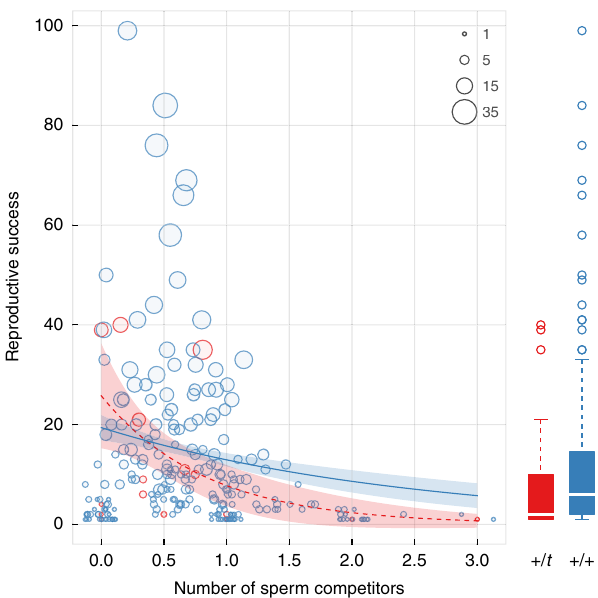
Fig. 2 Sperm competition damages the fi tness of t haplotype males. The fi gure shows the reproductive success of 249 males as a function of sperm competition intensity (measured as the number of sperm competitors a male encountered during his lifetime) and t genotype (red for + /t and blue + / + males). Dot size is proportional to the number of litters in which a male sired at least one offspring. Red/dotted and blue/solid lines with shaded areas show mean GLM model predictions and 95% con fi dence bands for + /t and + / + males, respectively (based on a hypothetical male that reproduced 10 times). Reproductive success was lower in males that were exposed to elevated levels of sperm competition, but the effect is particularly strong in drive carrying males. Low drive male fi tness under sperm competition translated into a lower reproductive output of + /t males overall, as illustrated by boxplots on the right (showing median (line), 0.25 and 0.75 quartiles (box) ± 1.58 times the inter-quartile range (whiskers)). Source data are provided as a Source data fi